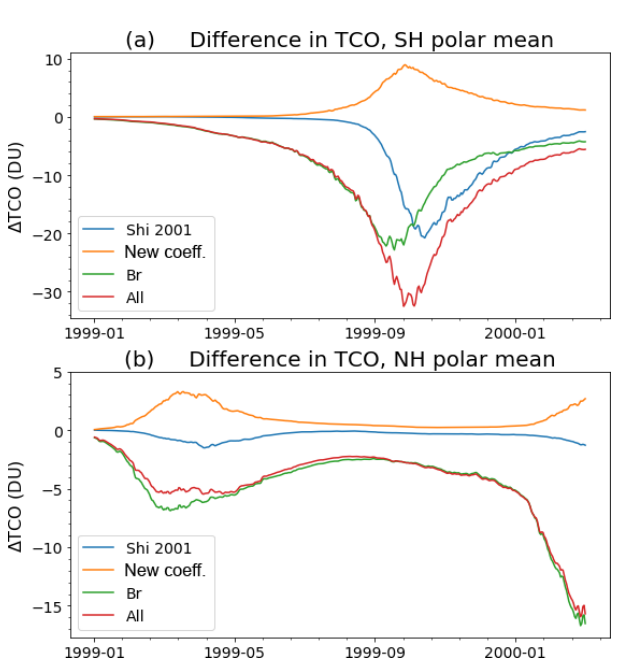
Figure 4. The difference in mean total column ozone (a) south of 65 ◦ S and (b) north of 65 ◦ N, between the various sensitivity runs and the control